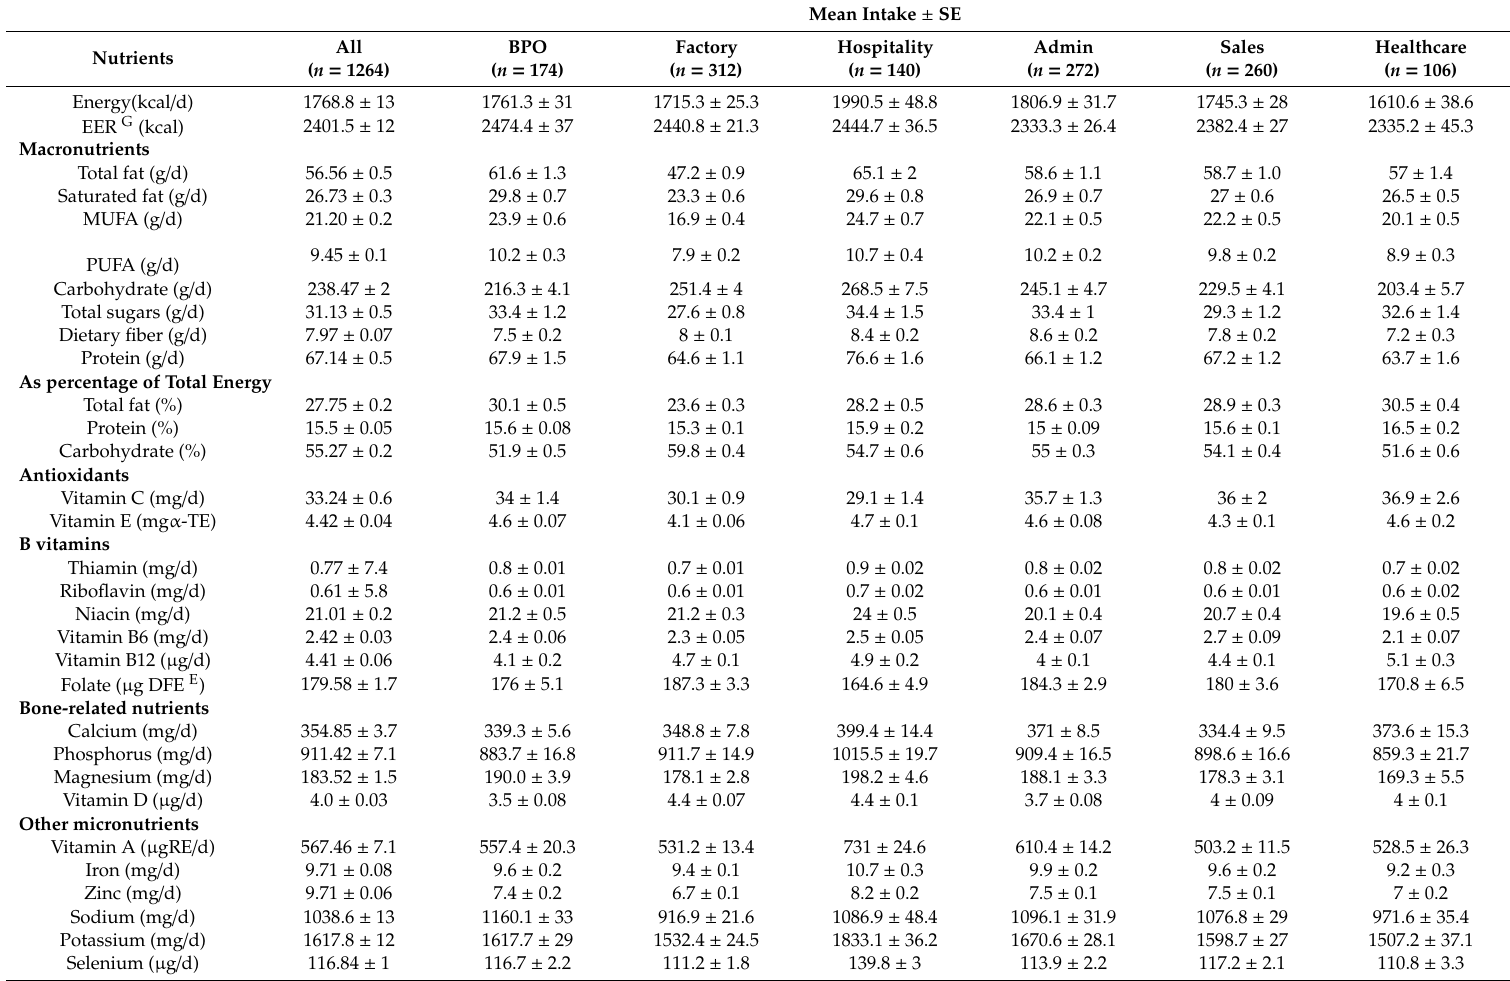
Table 3. Mean energy and nutrient intake of working adults by